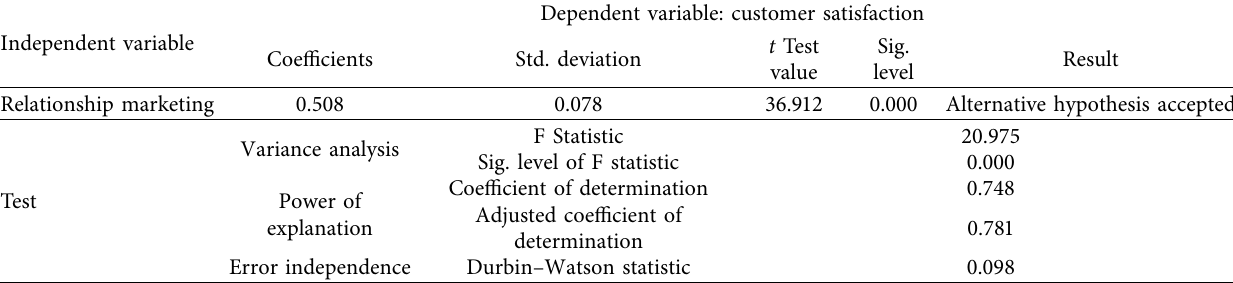
Table 9: Regression test results.